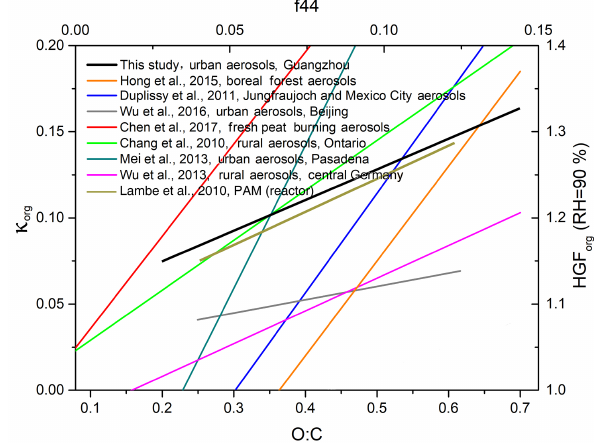
Figure 11. Closure analysis with the best fitting between the mea- sured HGFs and the ACSM-derived ones using the O : C-dependent HGF org for 145nm particles during the polluted and clean days. The equation is the achieved approximation for HGF org as a func- tion of the O : C of organic aerosol fraction. During the polluted days, HGF org is less sensitive to the changes in the O : C ratio of organic material compared with the ones during the clean days, in- dicating different organic species during these two distinct periods.